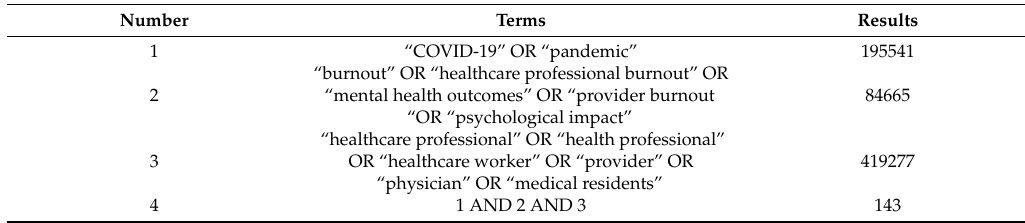
Table 1. The results of the individual search terms after running through Medline and Embase (OVID) for burnout in physicians during